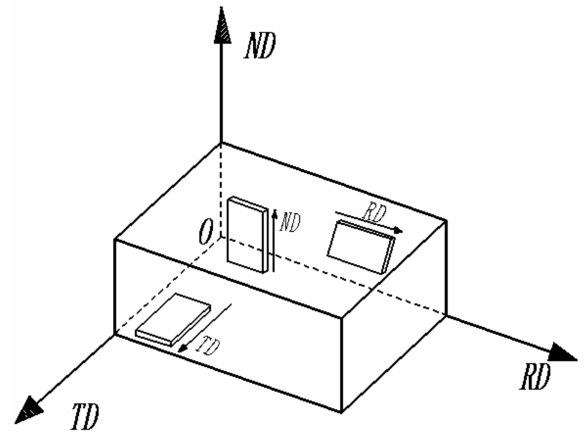
Figure 1. The selection direction of specimens. ND: Normal direction; TD: Transverse direction; RD: Rolling direction.